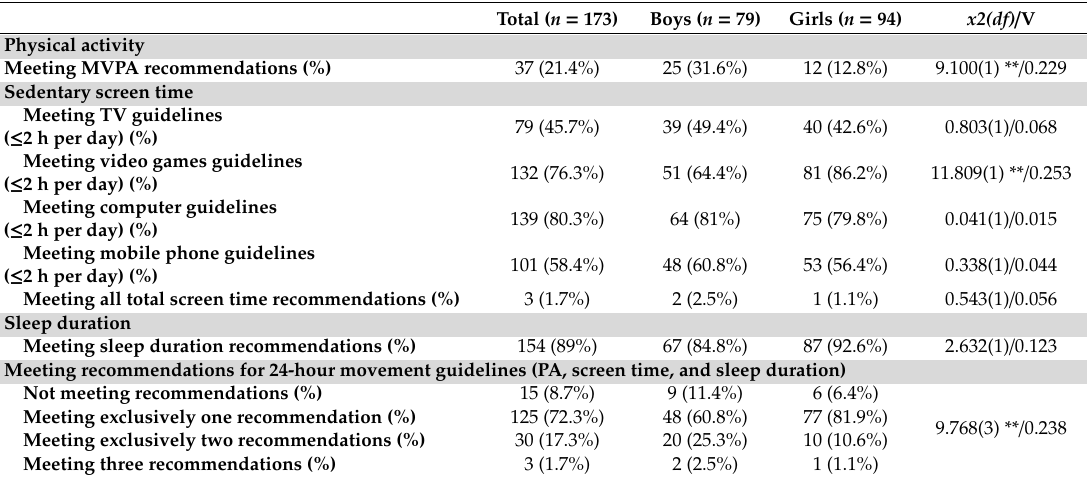
Table 2. Compliance with MVPA, screen time, and sleep duration recommendations and combinations of these recommendations by sex.